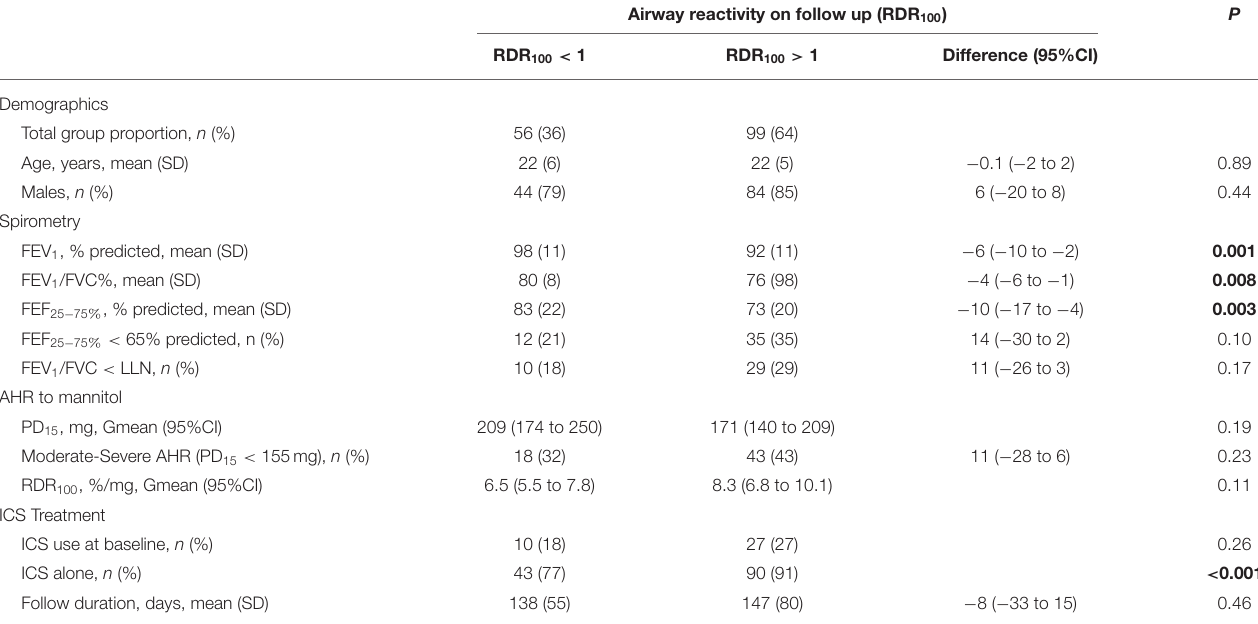
TABLE 4 | Recruits baseline demographics, spirometry, AHR and ICS treatment; Grouped based on airway reactivity (RDR 100 ) at follow-up ICS treatment visit. Airway reactivity on follow up (RDR 100 )